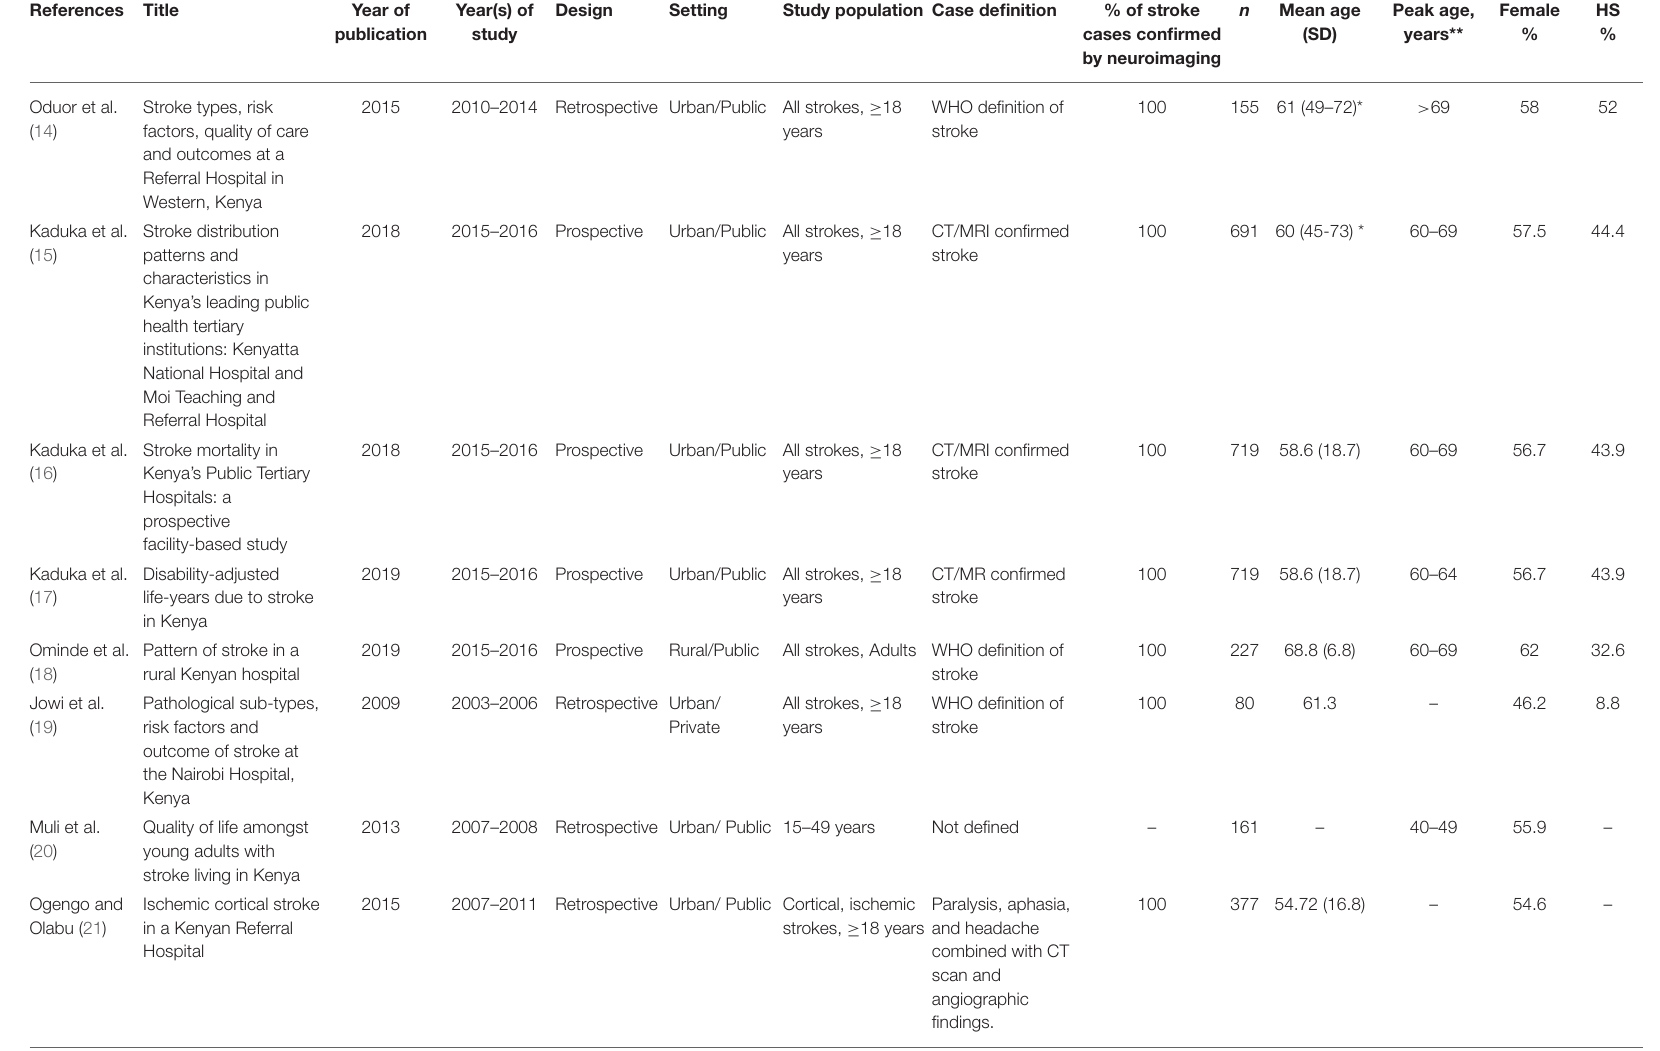
TABLE 1 | Characteristics of included